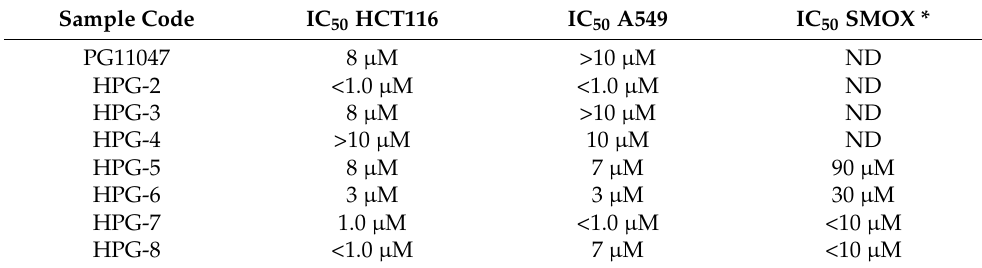
Table 2. Evaluation of inhibition of SMOX, HCT116, and A549 cell